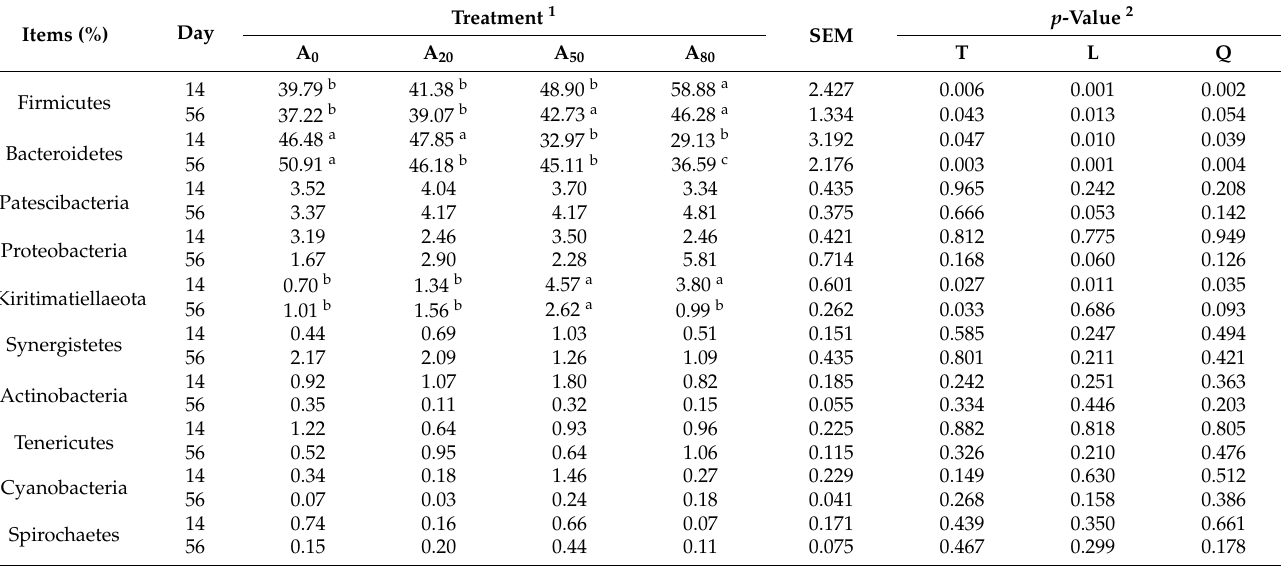
Table 3. The effect of supplementary Astralagus membranaceus (AMT) on rumen bacteria composition at the phylum level of Tibetan